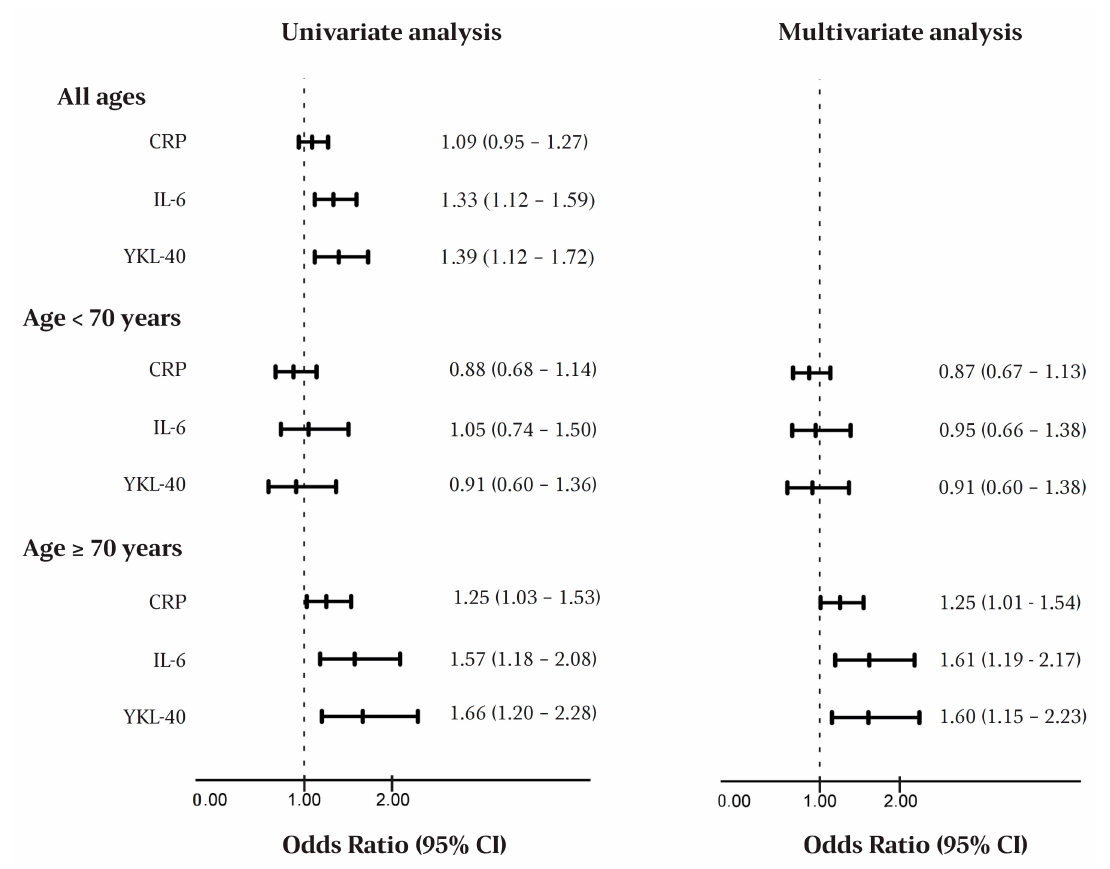
Figure 2. Forest plot illustrating inflammatory biomarker association with major complications, calculated as odds ratios. The multivariate analysis includes Charlson comorbidity index, sex, and age. Abbreviations: CRP, C-reactive protein; and IL-6, interleukin-6. Table 4. Clinical covariates and inflammatory biomarkers’ association with major